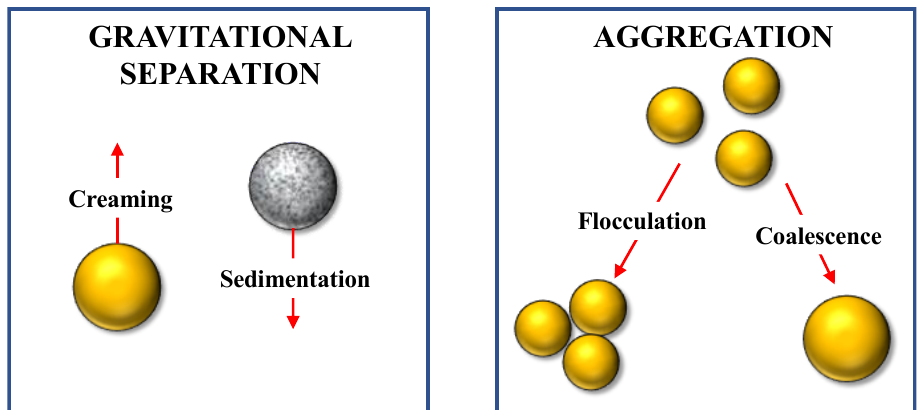
Figure 4. The oil droplets, oil bodies, or plant tissue fragments in plant-based milk substitutes can separate or aggregate, thereby reducing product stability.